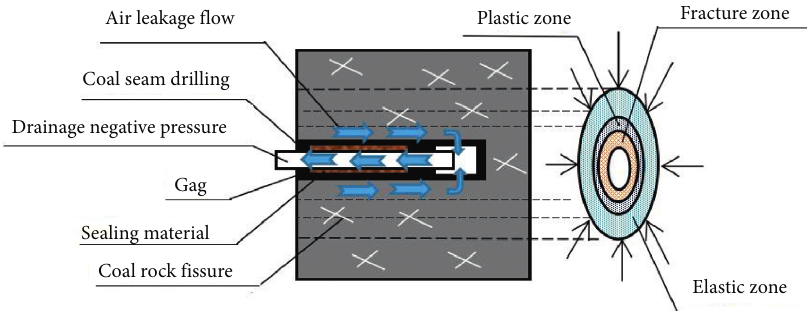
Figure 1: Air leakage schematic diagram of borehole broken coal rock.